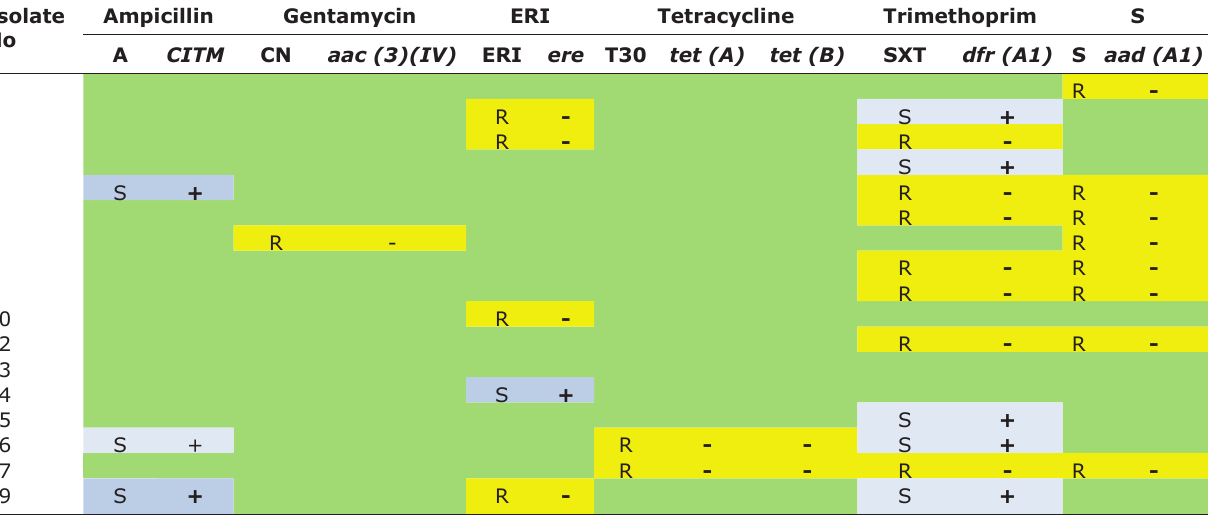
Table-5: E. coli showing an antibiotic pattern and gene detection P+ G− (Yellow), P− G+ (blue), and P+ G+ (light green). Isolate Ampicillin Gentamycin ERI No